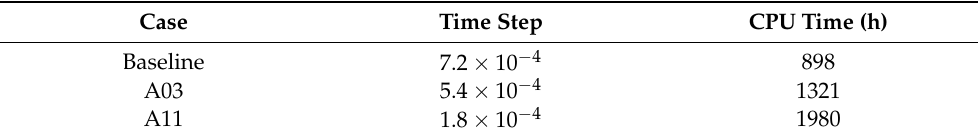
Table 2. Computational cost.